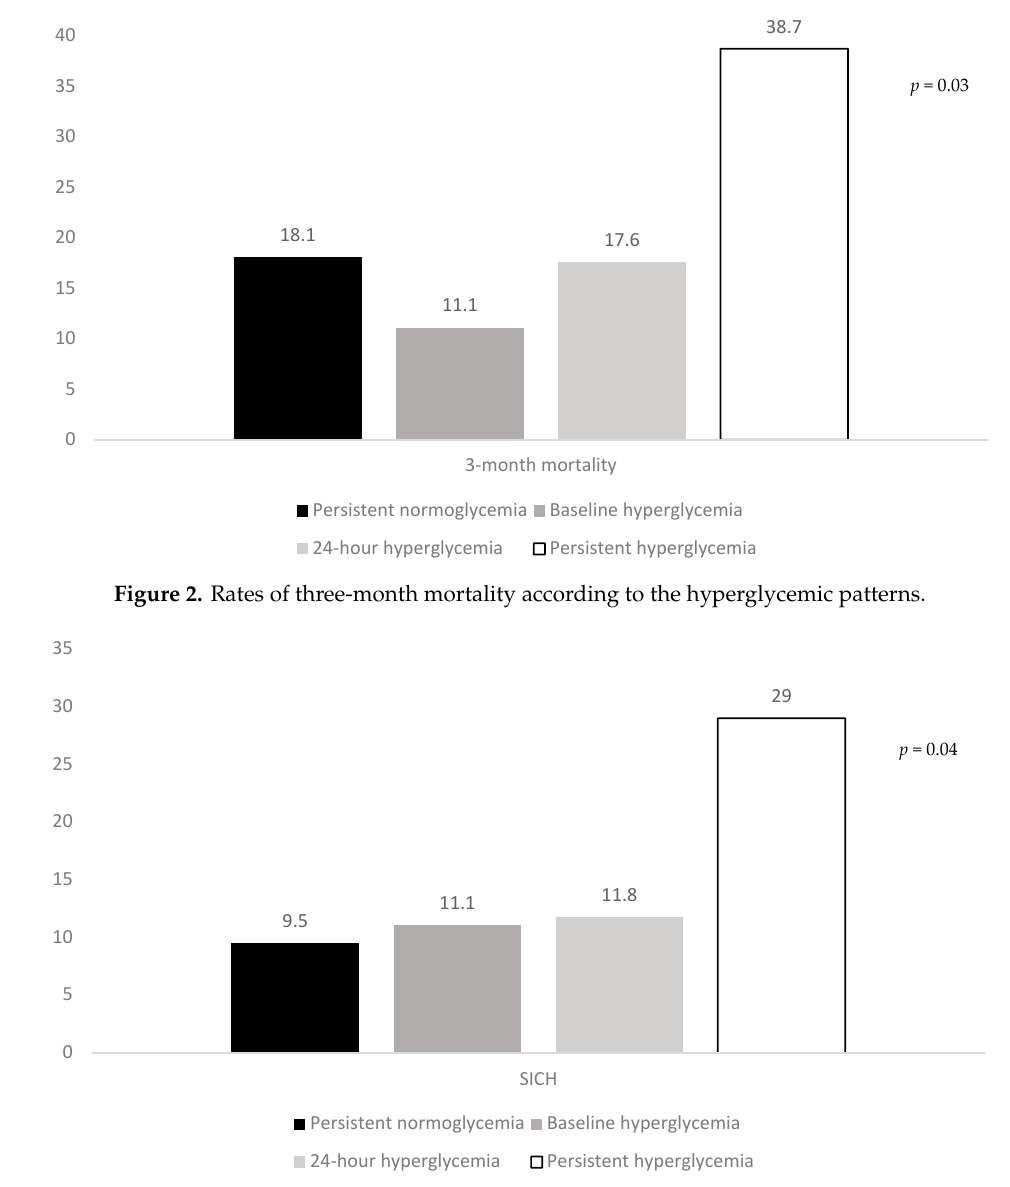
Figure 3. Rates of SICH according to the hyperglycemic patterns. SICH: symptomatic intracranial hemorrhage.